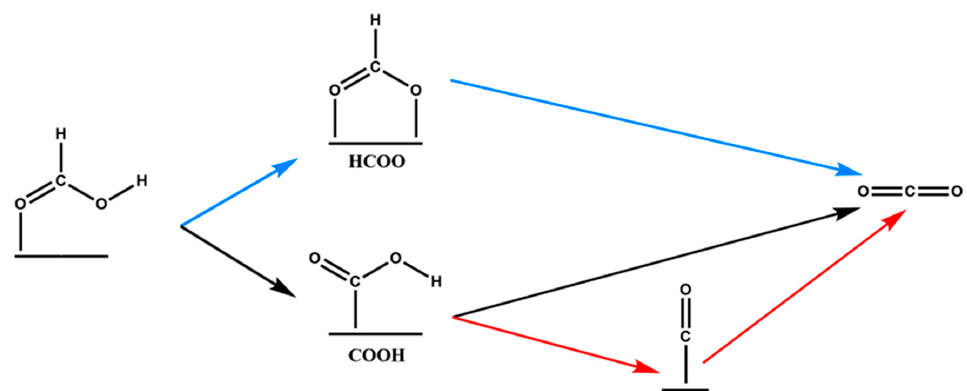
Figure 4. A general formic acid oxidation mechanism on Pd and Pt anodes of direct formic acid fuel cells (DFAFCs) by Elnabawy et al. Paths: blue, direct via formate; black, direct via carboxyl; and red, indirect via carboxyl. Reproduced from [12].